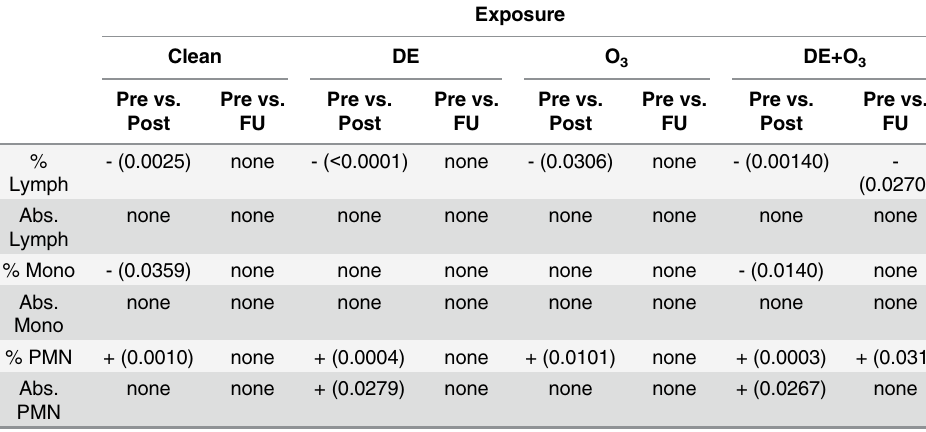
a “ +/- ” = statistically signi fi cant increase/decrease, (p-value), % = percent of total white blood cell count, Abs. = # cells * 10 3 /uL, Lymph = lymphocytes, mono = monocytes, PMN = polymorphonuclear neutrophil, FU = follow-up sampling time on Day